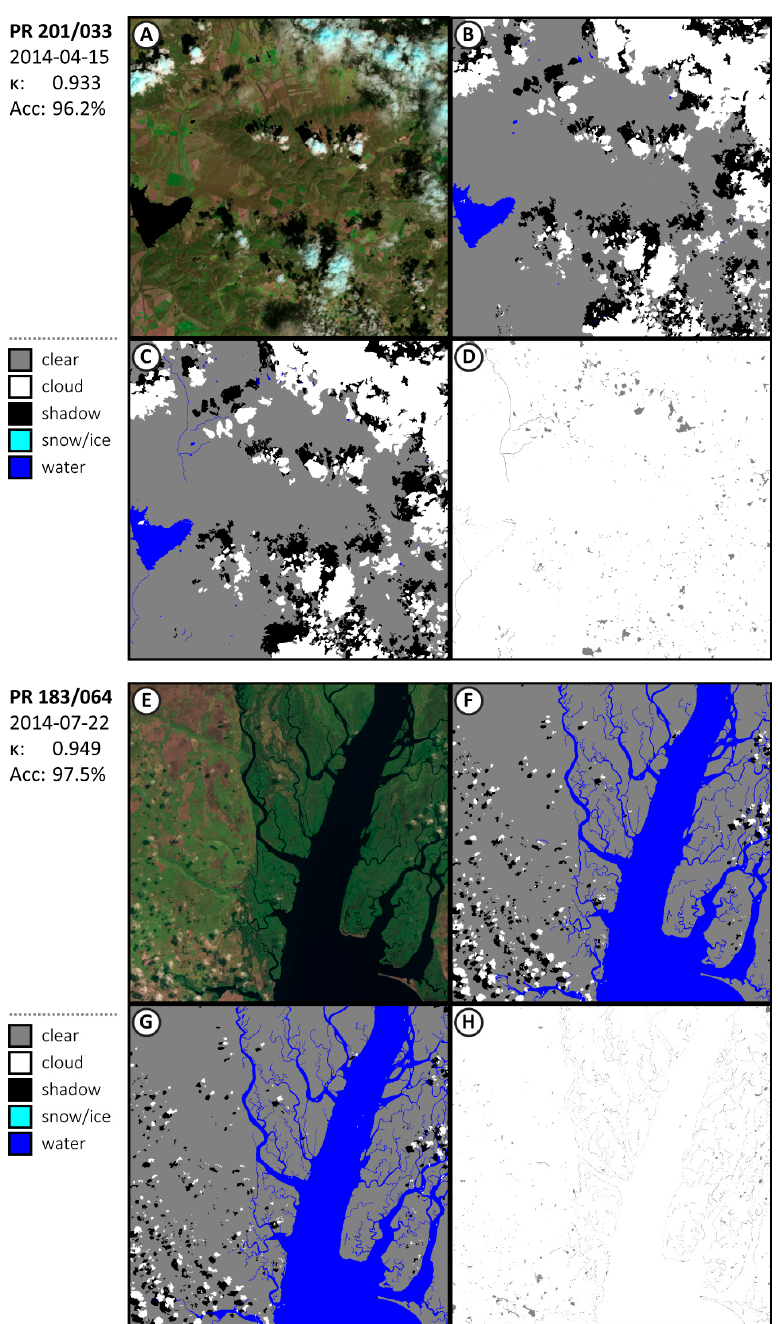
Figure 5. Interpreter self-disagreement for two images from PR 201/033 (top) and PR 183/064 (bottom). Both images were manually labeled by the same interpreter twice, each one year apart. Within each inset: false color image ( A , E ), both interpretations ( B , C , F , G ), and the areas of disagreement highlighted in grey (D, H).